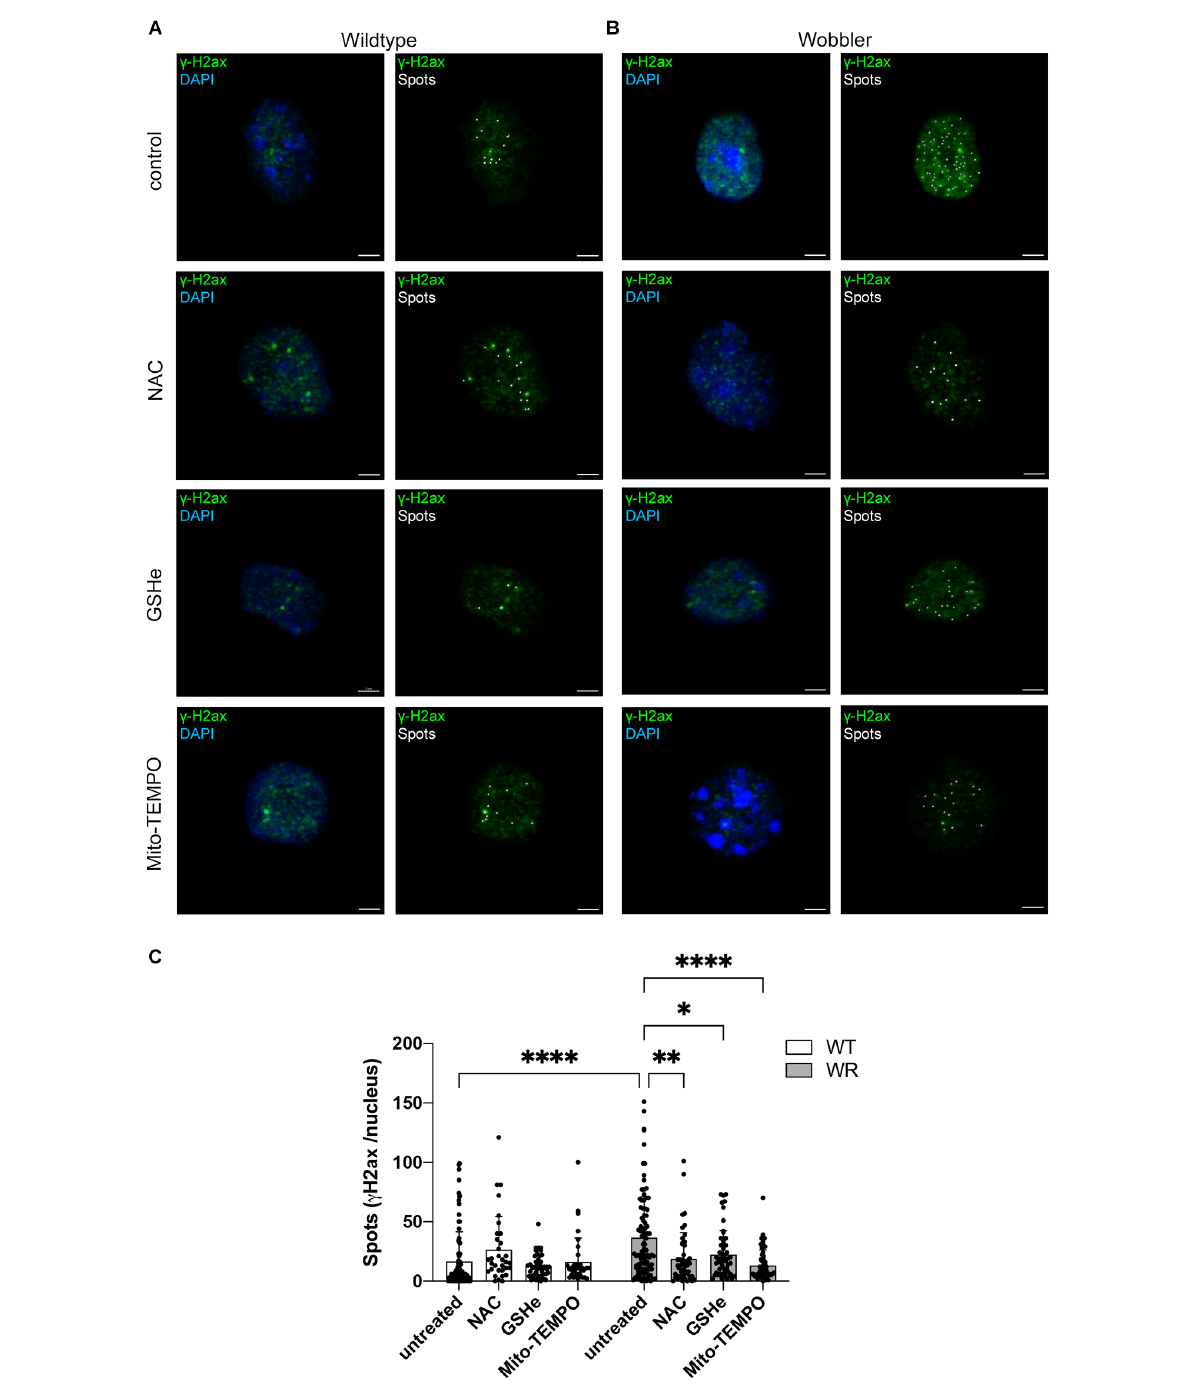
FIGURE4 Altered γ H2ax Spots in Wobbler motor neuronal nuclei after treatment with ROS scavengers NAC, GSHe, and Mito-TEMPO. (A,B) Exemplary images of untreated control and NAC-, GSHe-, and Mito-TEMPO-treated wild-type (A) and Wobbler (B) motor neurons. Nuclei were stained with DAPI (blue) and DNA damage response protein γ H2ax (green). Pictures were taken with a confocal fluorescent microscope equipped with a 40 × oil objective. Amount of γ H2ax and thus double strand breaks was analyzed with the spots function (white) of Imaris 9.3.1. Scale bar = 2 µ m. (C) Evaluation of the spots number of untreated control and NAC-, GSHe- and Mito-TEMPO-treated wild-type (WT) and Wobbler (WR) motor neurons at stable clinical phase (p40+10div). Data are provided as means ± SD including individual data points. Data were tested for significance using two-way ANOVA with a Sidak post-hoc test. Significant differences are indicated by ∗ p < 0.05, ∗∗ p < 0.01, ∗∗∗∗ p < 0.0001, n = 35–55 nuclei per genotype of a least five